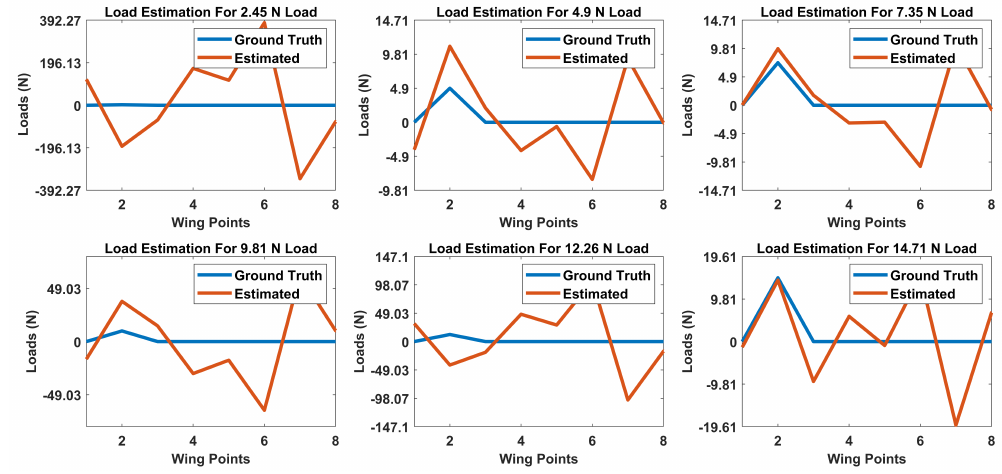
Figure A2. Load estimations for concentrated loads acting at point 2 of the wing.